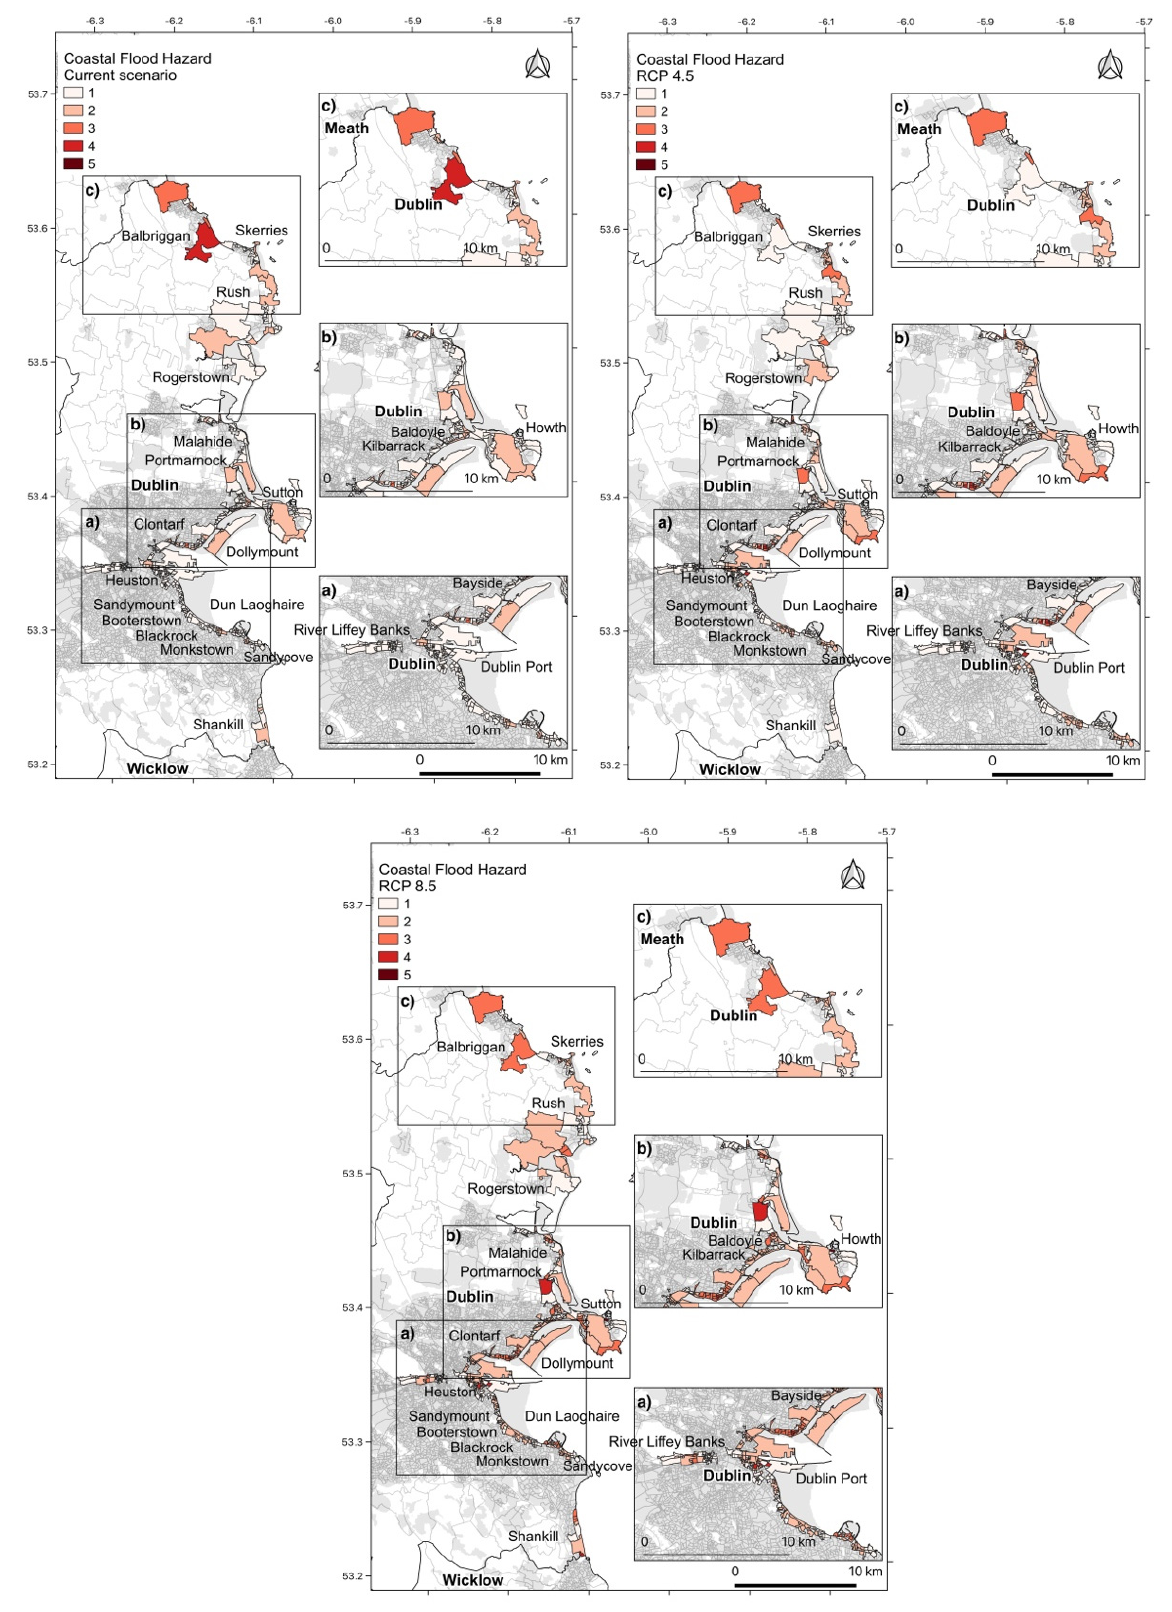
Figure 4. Coastal Flood Hazard index (H) across County Dublin. The index ranges from 1 (very low hazard) to 5 (very high hazard). Panels information as in Figure 3.